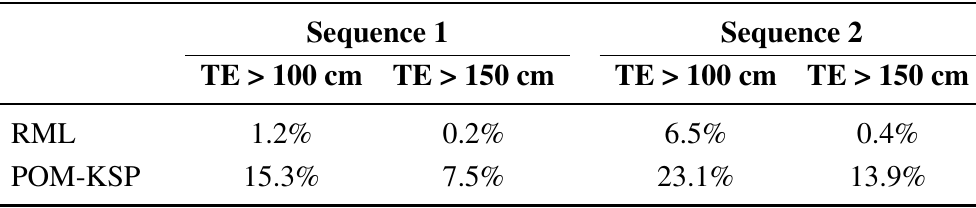
Table 2. Percentage of frames with TE larger than different threshold values for RML and